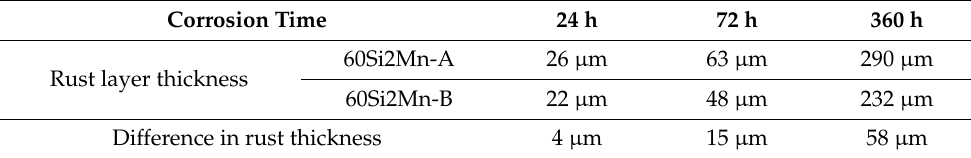
Figure 4. Section micromorphology of rust layer of experimental steel after corrosion for different time: ( a – c ) 60Si2Mn-B after corrosion for 24 h, 72 h, and 360 h; ( d – f ) 60Si2Mn-A after corrosion for 24 h, 72 h, and 360 h. Table 2. Thickness of rust layer of experimental steel after corrosion for different